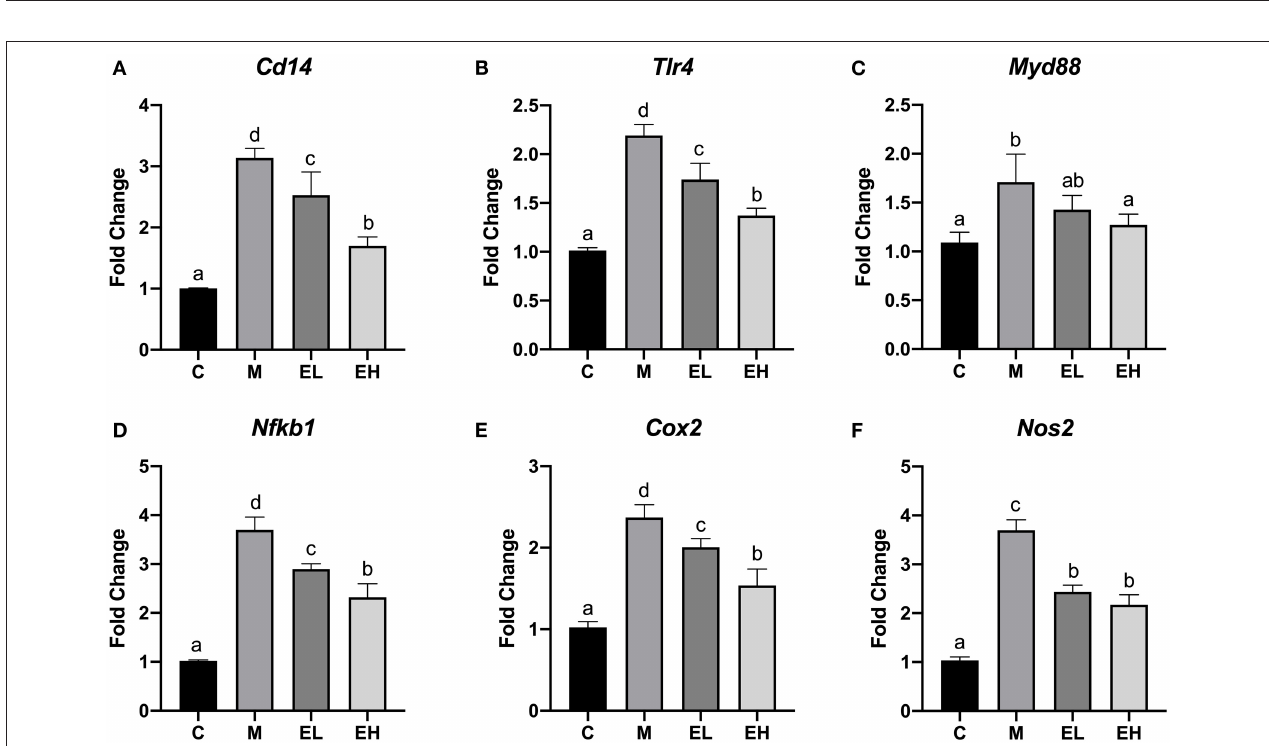
FIGURE 6 | Effect of ellagic acid on hepatic pro-inflammatory cytokines levels in mice. (A) TNF- α ; (B) IL-1 β ; (C) IL-6. Values represent the mean ± SD ( n ≥ 6). Labeled means without a common letter difference. p < 0.05 by one-way ANOVA followed by Duncan’s test. C, normal group; M, model group; EL, low dose of ellagic acid group; EH, high dose of ellagic acid group.